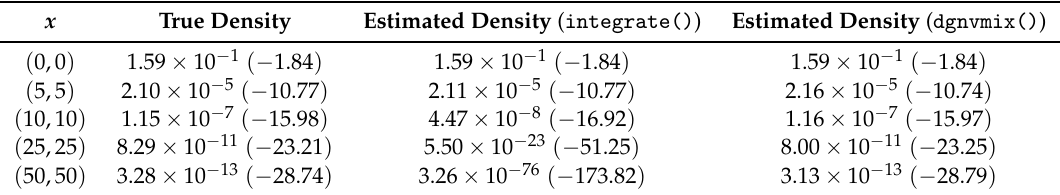
Table 1. Estimated and true density values of a bivariate t distribution with 6 degrees of freedom. Logarithmic values are in brackets.